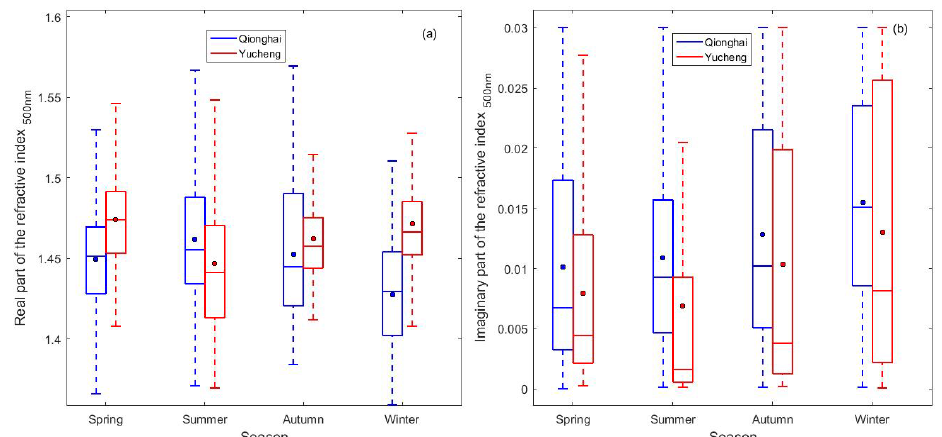
Figure 13. Seasonal variations in the real part of the refractive index (a) and the imaginary part of the refractive index (b) based on SKYRAD V5.0 over Qionghai and Yucheng for the period from February 2013 to December 2015. The boxes represent the 25th to 75th percentiles of the distributions, while the dots and solid lines within each box represent the means and medians,